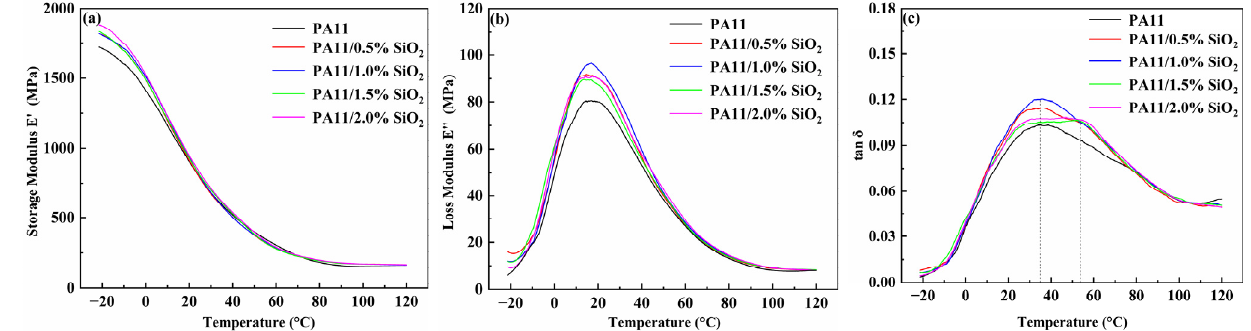
Figure 9. ( a ) Storage modulus, ( b ) loss modulus, and ( c ) tan δ of neat PA11 along with PA11/SiO 2 composites.